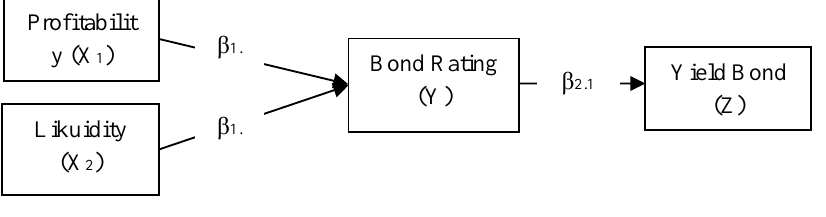
Figure 1: Path Analysis Estimation